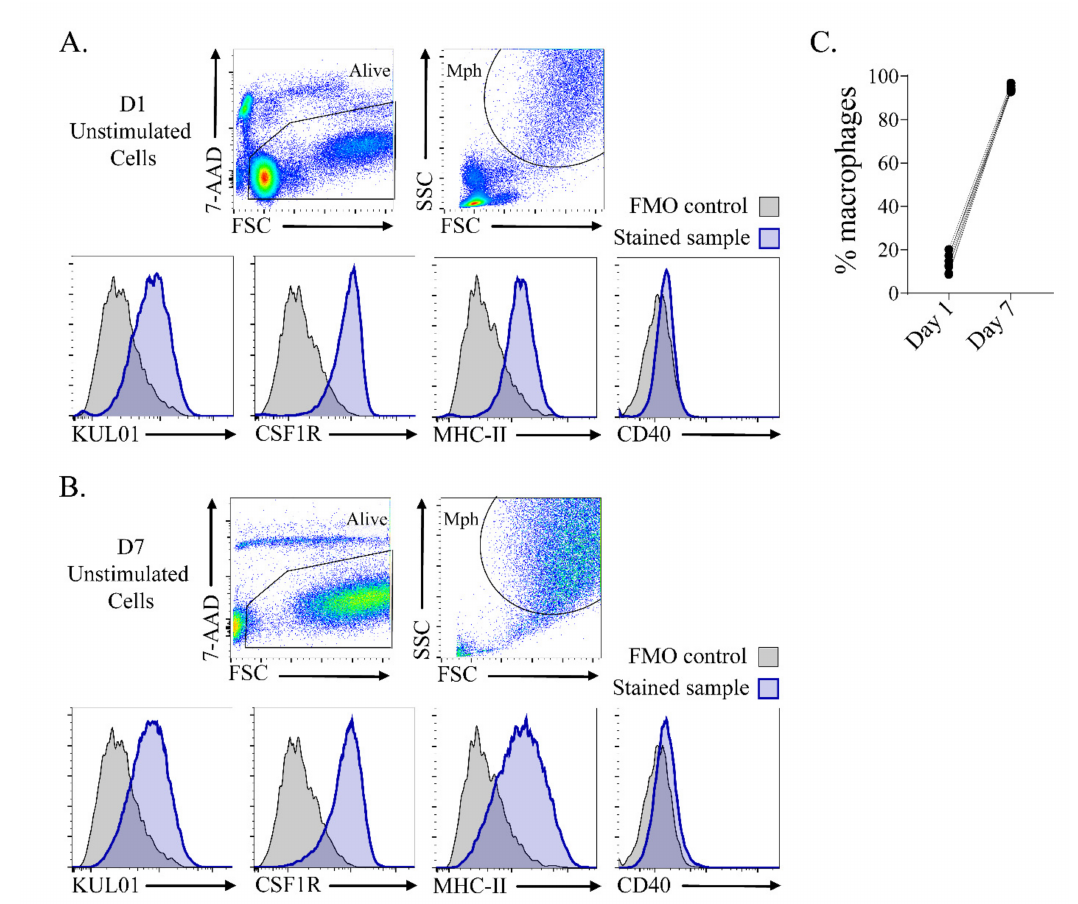
Figure 2. Adherent cells di ff erentiated to KUL01 + CSF1R + MHC-II + macrophages (Mph) after 7 days of culture. ( A ) Adherent cells were characterized after 24 h of culture by flow cytometry. ( B ) Adherent unstimulated cells were characterized after 7 days of culture by flow cytometry. The cells were selected for viability (7-AAD − ), forward and side light scatter (FSC vs. SSC), and assessed for the expression of KUL01, CSF1R, MHC-II and CD40. The histograms show expression of the macrophage markers in blue and fluorescent-minus-one (FMO) staining controls in grey. ( C ) The percentages of macrophages from day 1 and day